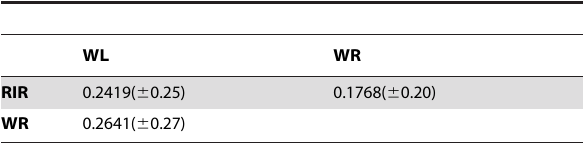
Table 2. Average F ST values with standard deviation between different breeds.